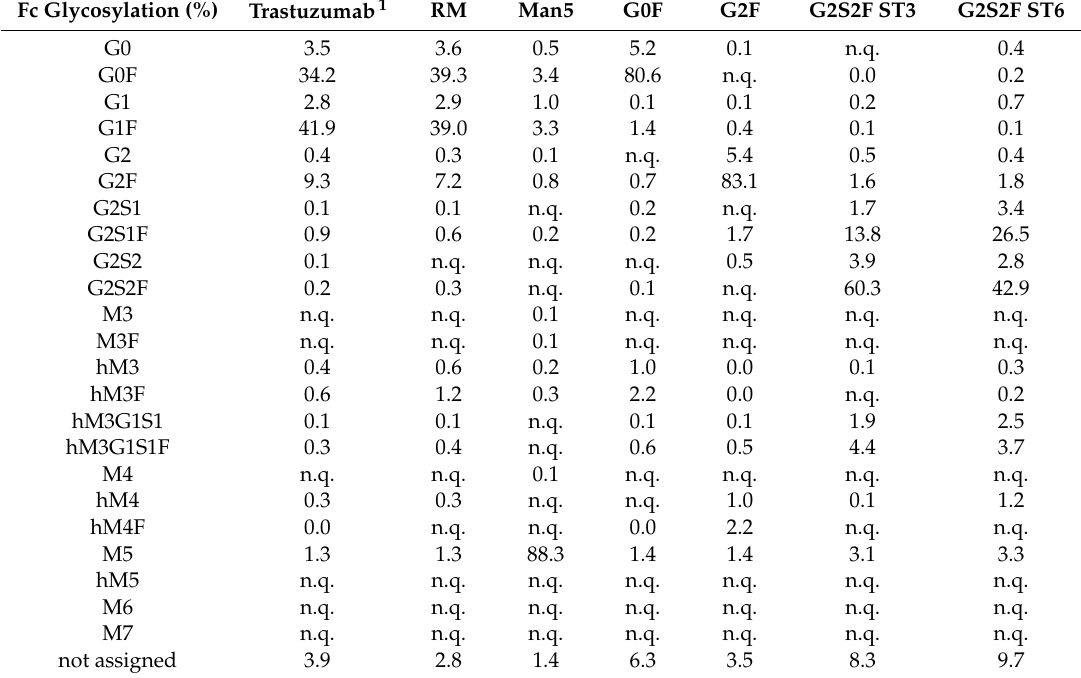
Table 1. Relative quantification of 2-AB labeled (trastuzumab) N-glycans (2-AB